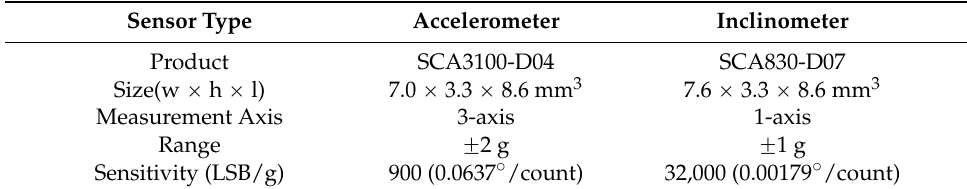
Table 1. Generic Data Sheet of the two Sensors Used in the Deployment.